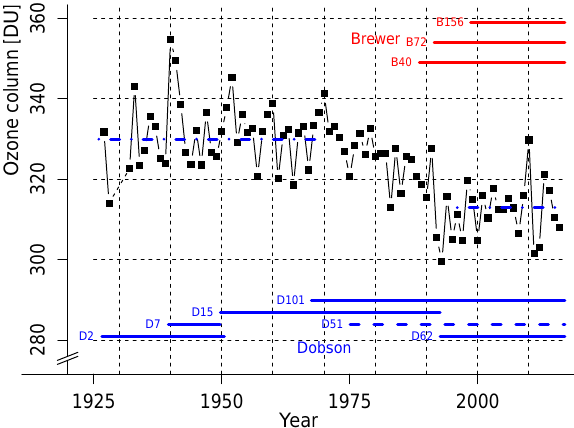
Figure 1. Time series of the annual mean ozone column above Arosa, Switzerland. The different instruments in operation are il- lustrated by blue segments for the Dobson and red segments for the Brewer instruments. Dobson D 051 is mostly dedicated to Umkehr measurements. The broken blue lines are the mean ozone column before 1970 and after